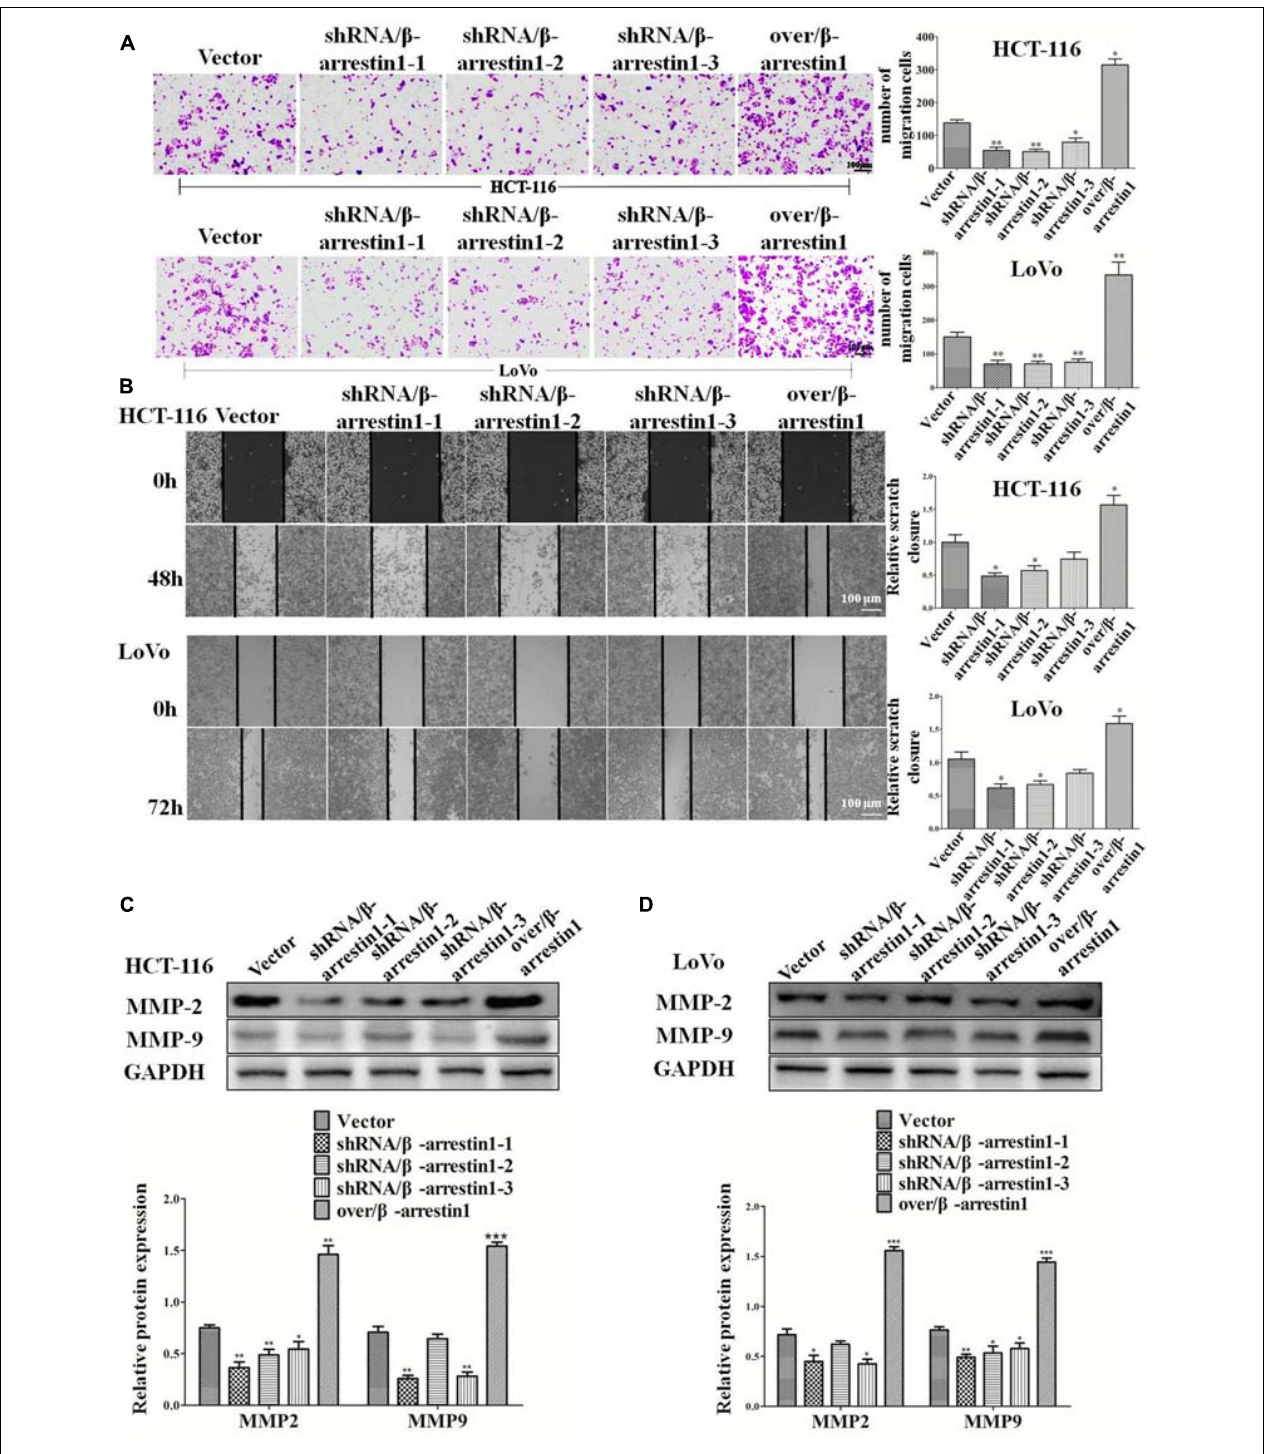
FIGURE 4 | β -arrestin1 promotes the migration of CRC cells. (A) HCT-116 or LoVo cells transfected with shRNA/ β -arrestin1 or over/ β -arrestin1 lentivirus were used in the Transwell experiment. Typical images of cells migrating in a transwell migration chamber were captured and quantitatively measured. * P < 0.05; ** P < 0.01 vs. HCT-116-vector or LoVo-vector cells. (B) shRNA/ β -arrestin1 or over/ β -arrestin1 cells were cultured to confluence at 4.5 × 10 5 cells on 6-well plates. Representative images and a bar graph of the wound-healing assay are presented. The black line was used to mark the ranges of the scratches. * P < 0.05 vs. HCT-116-vector or LoVo-vector cells. (C,D) MMP2 and MMP9 were examined via western blotting. * P < 0.05; ** P < 0.01; *** P < 0.001 vs. HCT-116-vector or LoVo-vector cells. CRC, colorectal cancer; shRNA, short hairpin RNA.